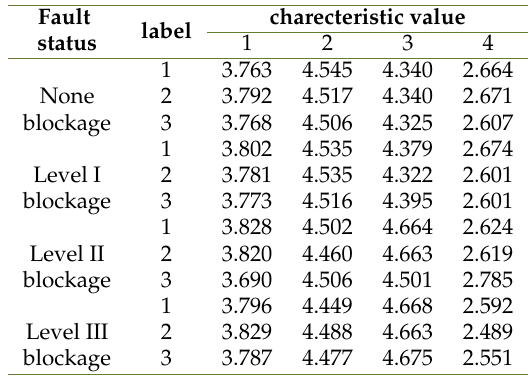
Fig. 8. Decomposition results of levelII blockage (a) and level III blockage (b) signals Table 1. Partial characteristic data of pipeline under different blocking faults Fault